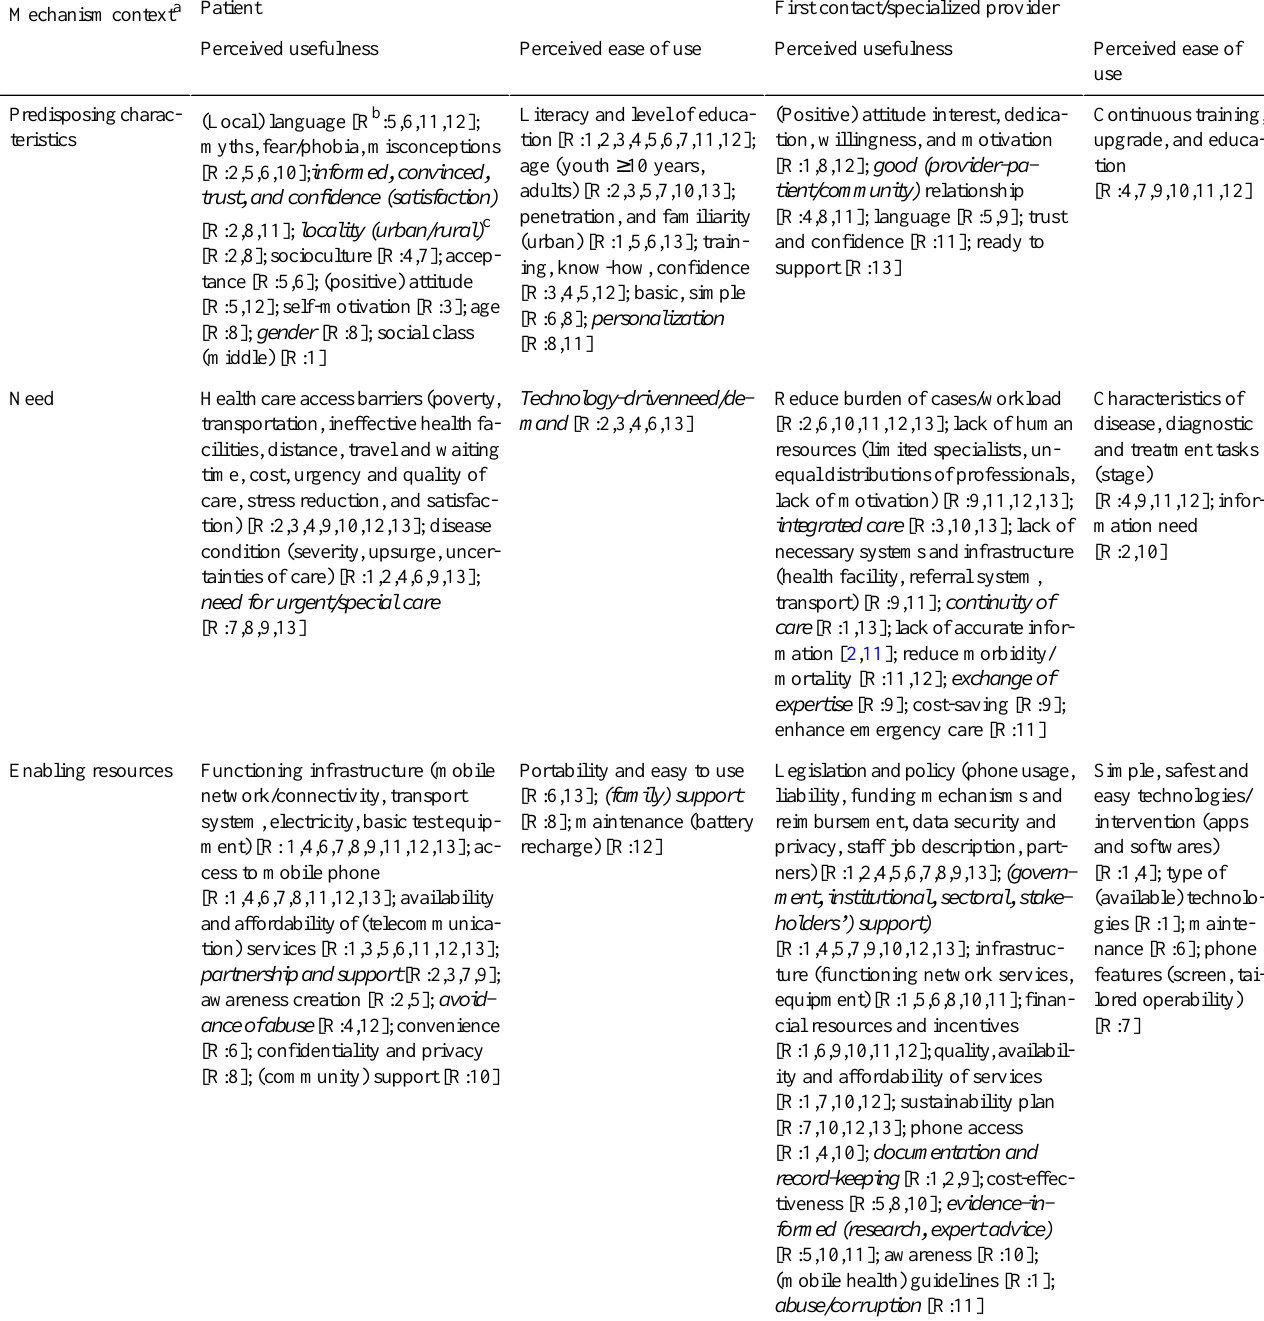
First contact/specialized providerPatientMechanism context